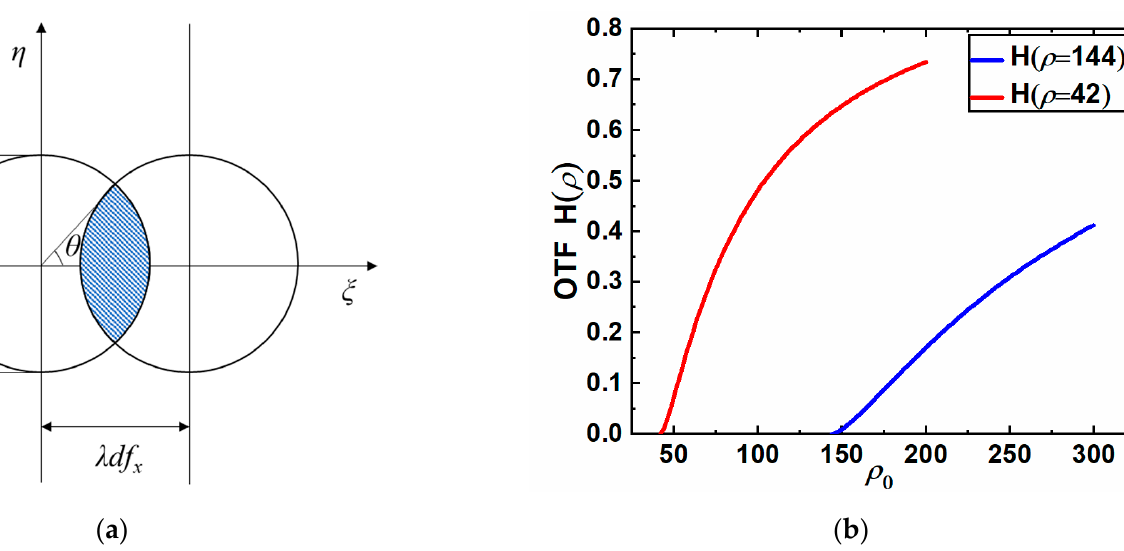
Figure 3. ( a ) The overlap area of the moved pupil and the original pupil. ( b ) the relation curve between the ρ 0 and the H ( ρ = 144 ) and the relation curve between the ρ 0 and the H ( ρ = 42 )